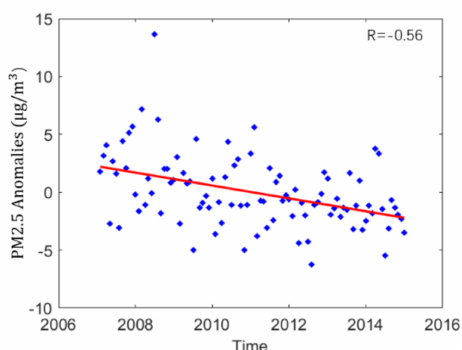
Figure 1. Eight years of monthly anomalies in aerosol particulate matter with aerodynamic diameter ≤ 2.5 µ m (PM 2.5 ) at Baltimore–Washington International Airport (BWI) station. The red line shows the linear regression.